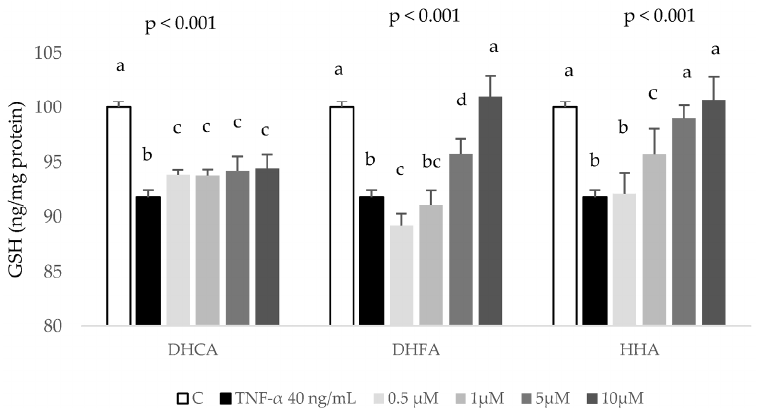
Figure 7. Effect of coffee microbial metabolites DHCA, DHFA, and HHA at 0 (control, C), 0.5, 1, 5 and 10 µM on depleted reduced glutathione (GSH) levels induced by TNF- α . HepG2 cells were cotreated with noted concentrations of the metabolites and TNF- α (40 ng/mL for 6 h) and GSH concentration was determined. Data are means ± SD of 3–4 different samples per condition. The p values above the figures represent ANOVA results and the different letters denote statistical differences according to the Bonferroni test within the same compound ( p < 0.05). However, recovery of TNF- α -decreased GSH levels was observed when cells were